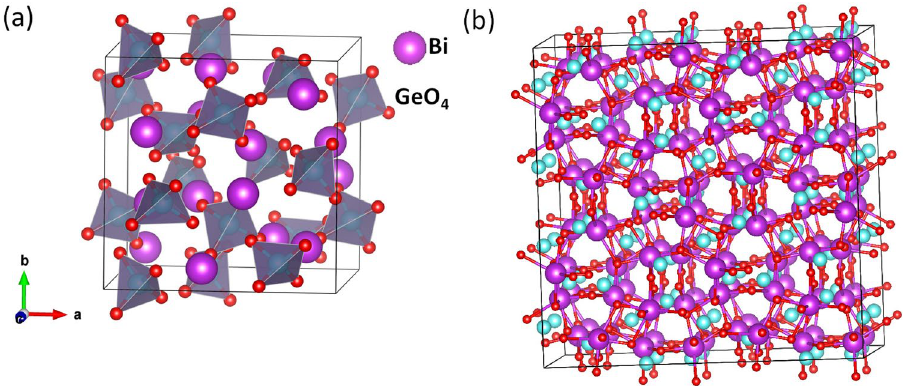
Figure 1. ( a ) Crystal structure of optimized BGO unit cell and ( b ) 2 × 2 × 2 supercell used for defect simulations.